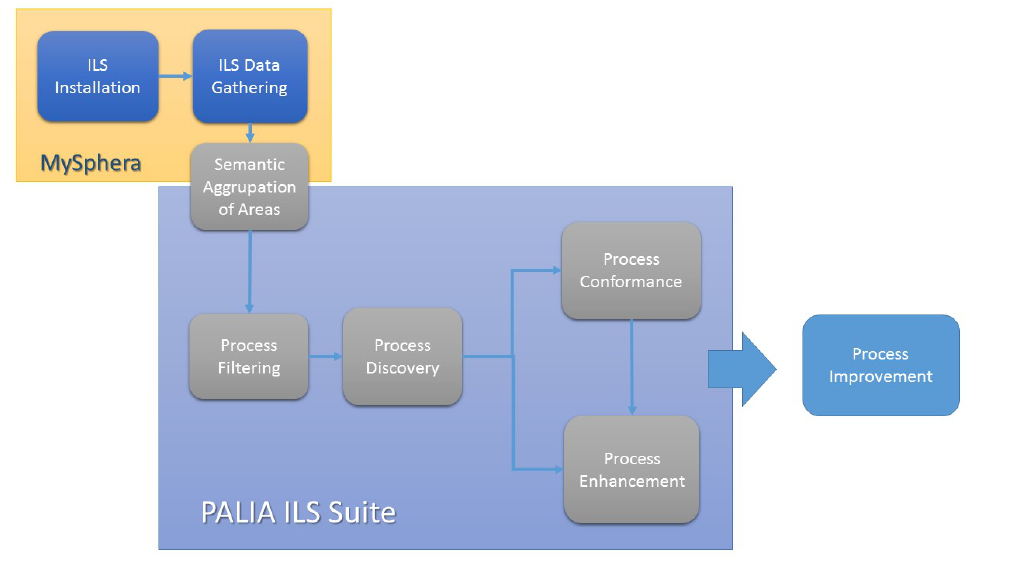
Figure 3. Scheme of the